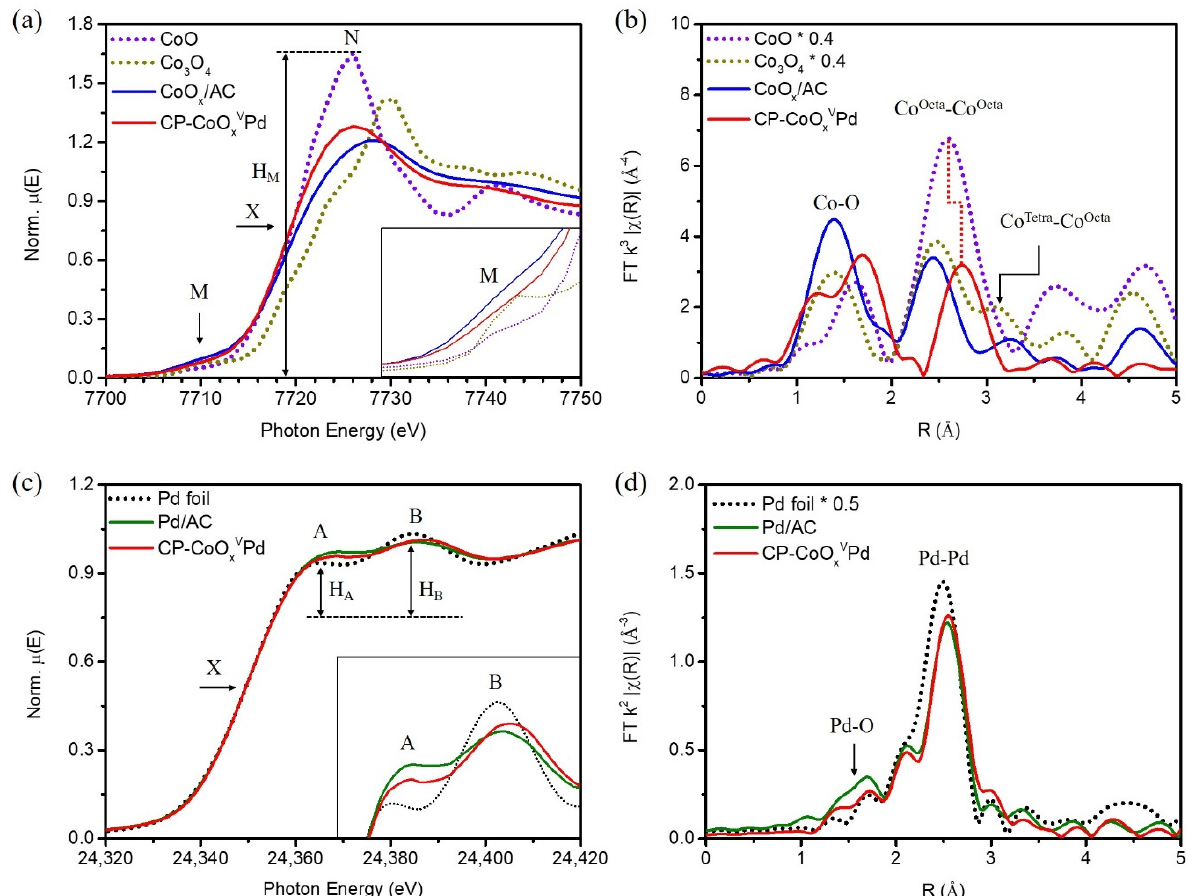
Figure 3. X-ray absorption spectroscopy of the experimental NCs compared with reference samples. ( a ) XANES and ( b ) FT-EXAFS spectra of the experimental NCs at Co K-edge. ( c ) XANES and ( d ) FT- EXAFS spectra of the experimental NCs at Pd K-edge. In the FT-EXAFS spectra at Co K-edge, peak Co Octa -Co Octa is the contribution of coordinated Co atoms at octahedral symmetry from the 2nd coordination shell in CoO lattice. The peak of Co Tetra -Co Octa is the contribution of coordinated Co atoms (tetrahedral symmetry) in the 2nd coordination shell of CoO x lattice. * The intensity of Pd foil is reduced by 50% for better representation.